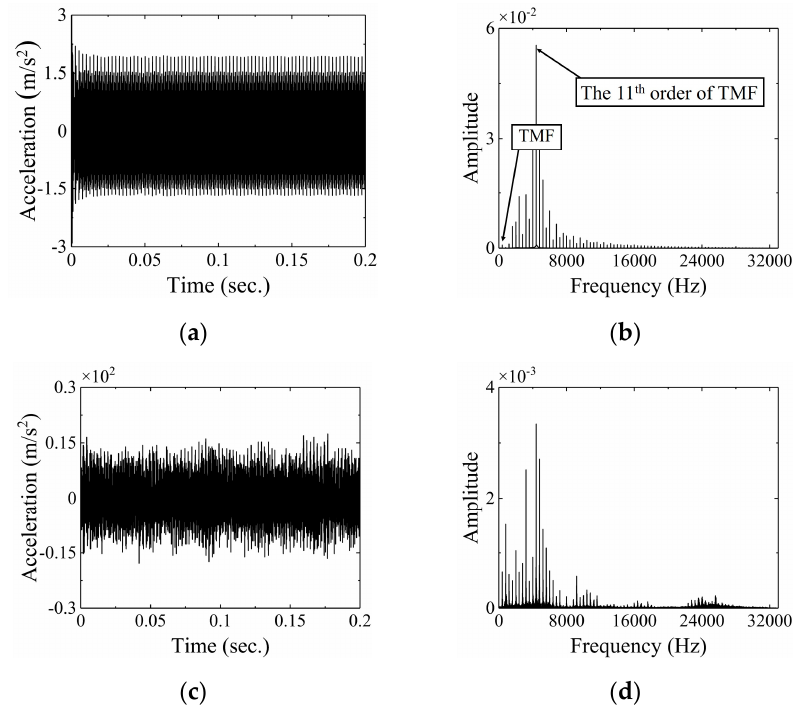
Figure 10. The simulated and experimental signal in the meshing line direction (healthy pinion): ( a ) simulated signal, ( b ) simulated frequency signal, ( c ) experimental signal, and ( d ) experimental frequency signal.